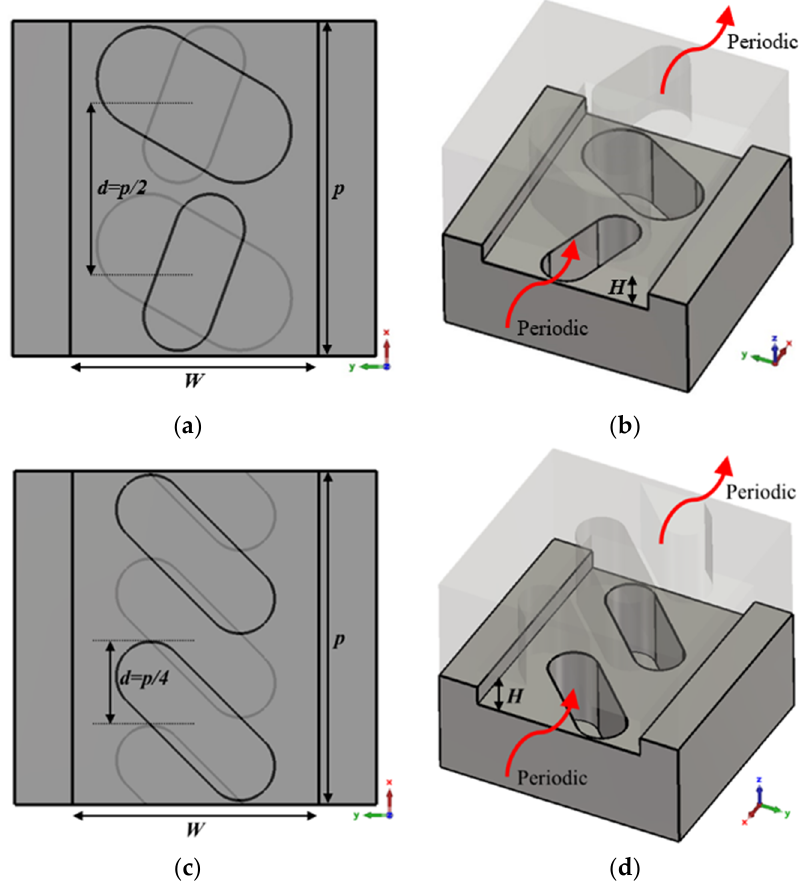
Figure 4. Glide symmetric unit cells for a single periodic configuration (top view ( a ) and perspective view ( b )) and for a double periodic configuration (top view ( c ) and perspective view ( d )) periodic in x -direction. Table 1. Description of the design parameters of the unit cells shown in Figures 1 and 4.